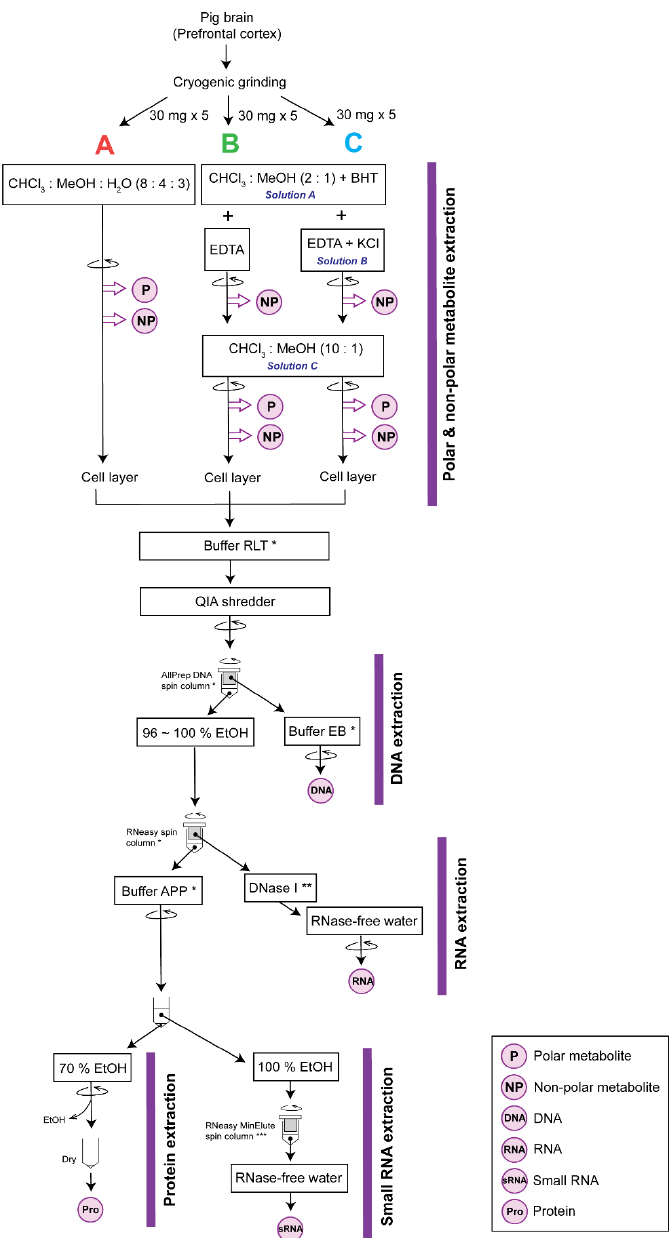
Figure 1. Overall schematic of the methods. Method A is the method proposed by Roume et al. [1]. Reagents with * are from the AllPrep DNA/RNA/Protein mini kit, ** from the RNase-Free DNase Set, and *** from the RNeasy MinElute cleanup kit. The round arrow indicates that centrifugation was applied at that step. Extracted analytes are indicated with purple circles. Abbreviations: CHCl3, chloroform; MeOH, methanol; H2O, water; EtOH, ethanol.